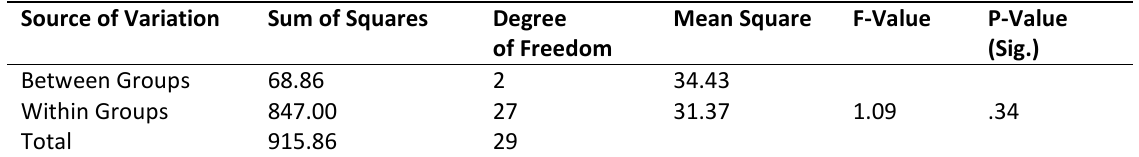
Table 5. One way analysis of variance (Anova) results among judo, taekwondo and boxing players with regard to the sub-parameter fetish Source of Variation